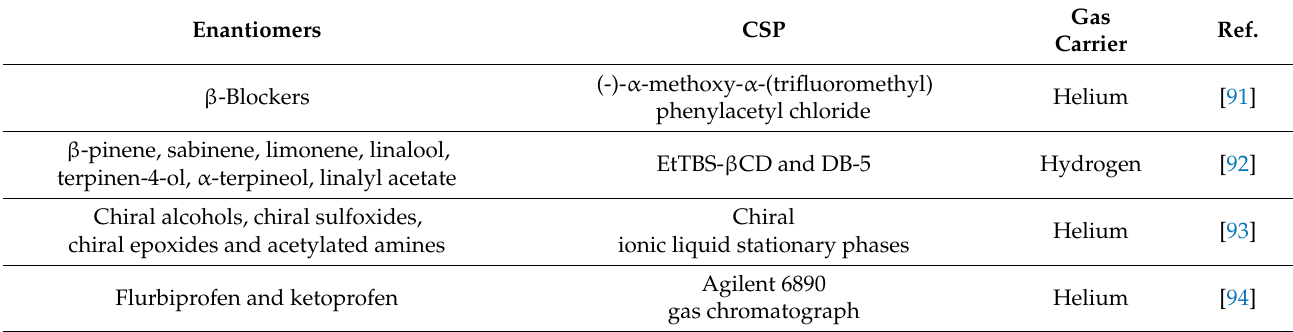
Table 7. Experimental studies of enantioresolutions applying gas